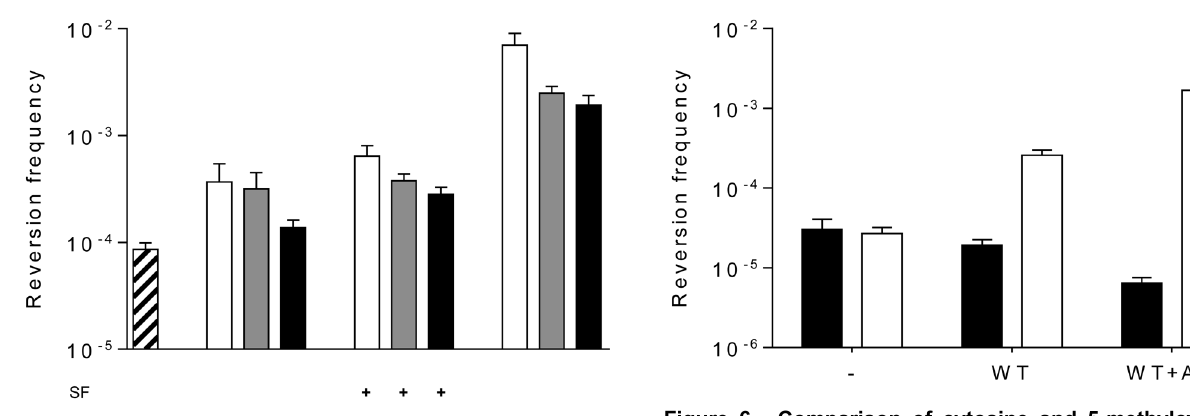
Figure 6. Comparison of cytosine and 5-methylcytosine deamination by M.SssI. Unmethylated and in vivo M.SssI- specifically methylated pUP41 plasmid DNA was incubated with or without M.SssI(WT) and 5’-amino-5’-deoxyadenosine as indicated using conditions described in the legend of Figure 1. unmethylated pUP41 in ER2357 ung (empty bars), whereas reversion frequency of methylated pUP41 was determined in DH10B ung + host (filled bars). Error bars represent standard error of the mean of at least three independent experiments